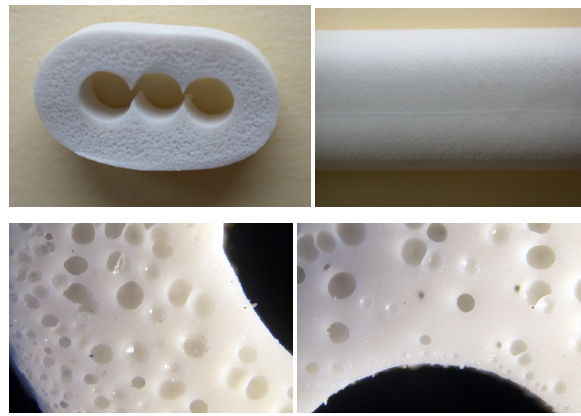
Figure 9: Microscope image of the cross section and longitudinal section of the cable covering made of cellular PVC at the amount of foaming agent 0.5%